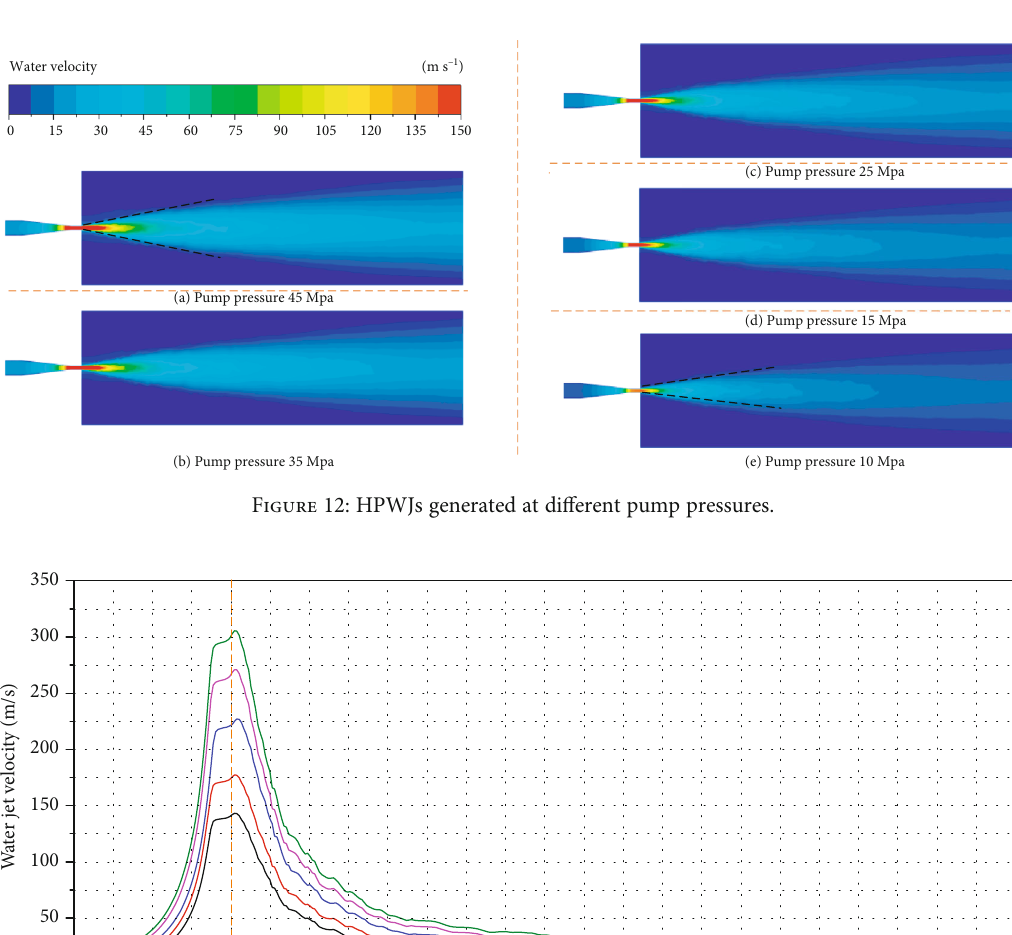
Figure 11: Contour maps of jet velocities under di ff erent nozzle angles.